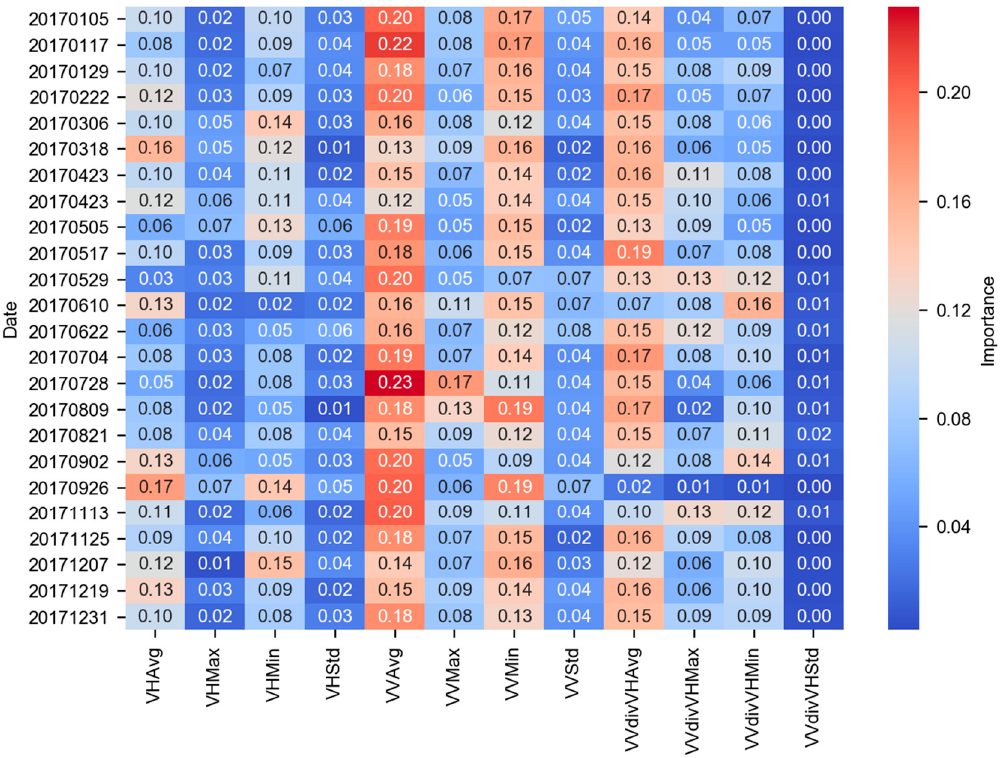
Figure 6. Variable importance for the Extra Tree classifier over 2017. VV = VV polarisation (dB); VH = VH polarisation (dB); VVdivVH = VV/VH ratio. Suffixes represent mean, maximum, minimum and standard deviation statistics respectively.